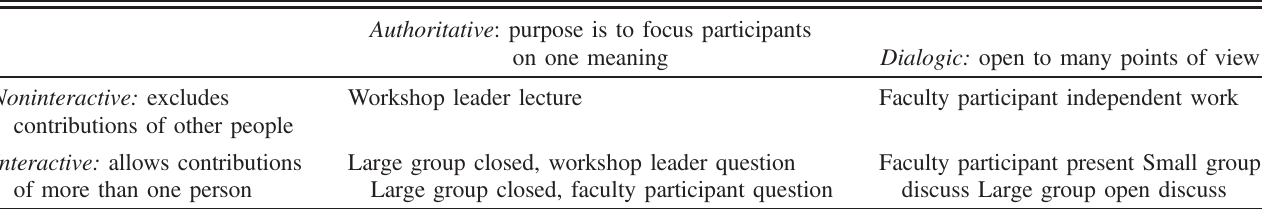
TABLE II. Locates the R-PDOT type-of-engagement codes within the four classes of communicative approaches — noninteractive and authoritative, noninteractive and dialogic, interactive and authoritative, and interactive and dialogic — defined in Scott et al. [28], Table 3, p. 611. These distinctions are discussed further in the main